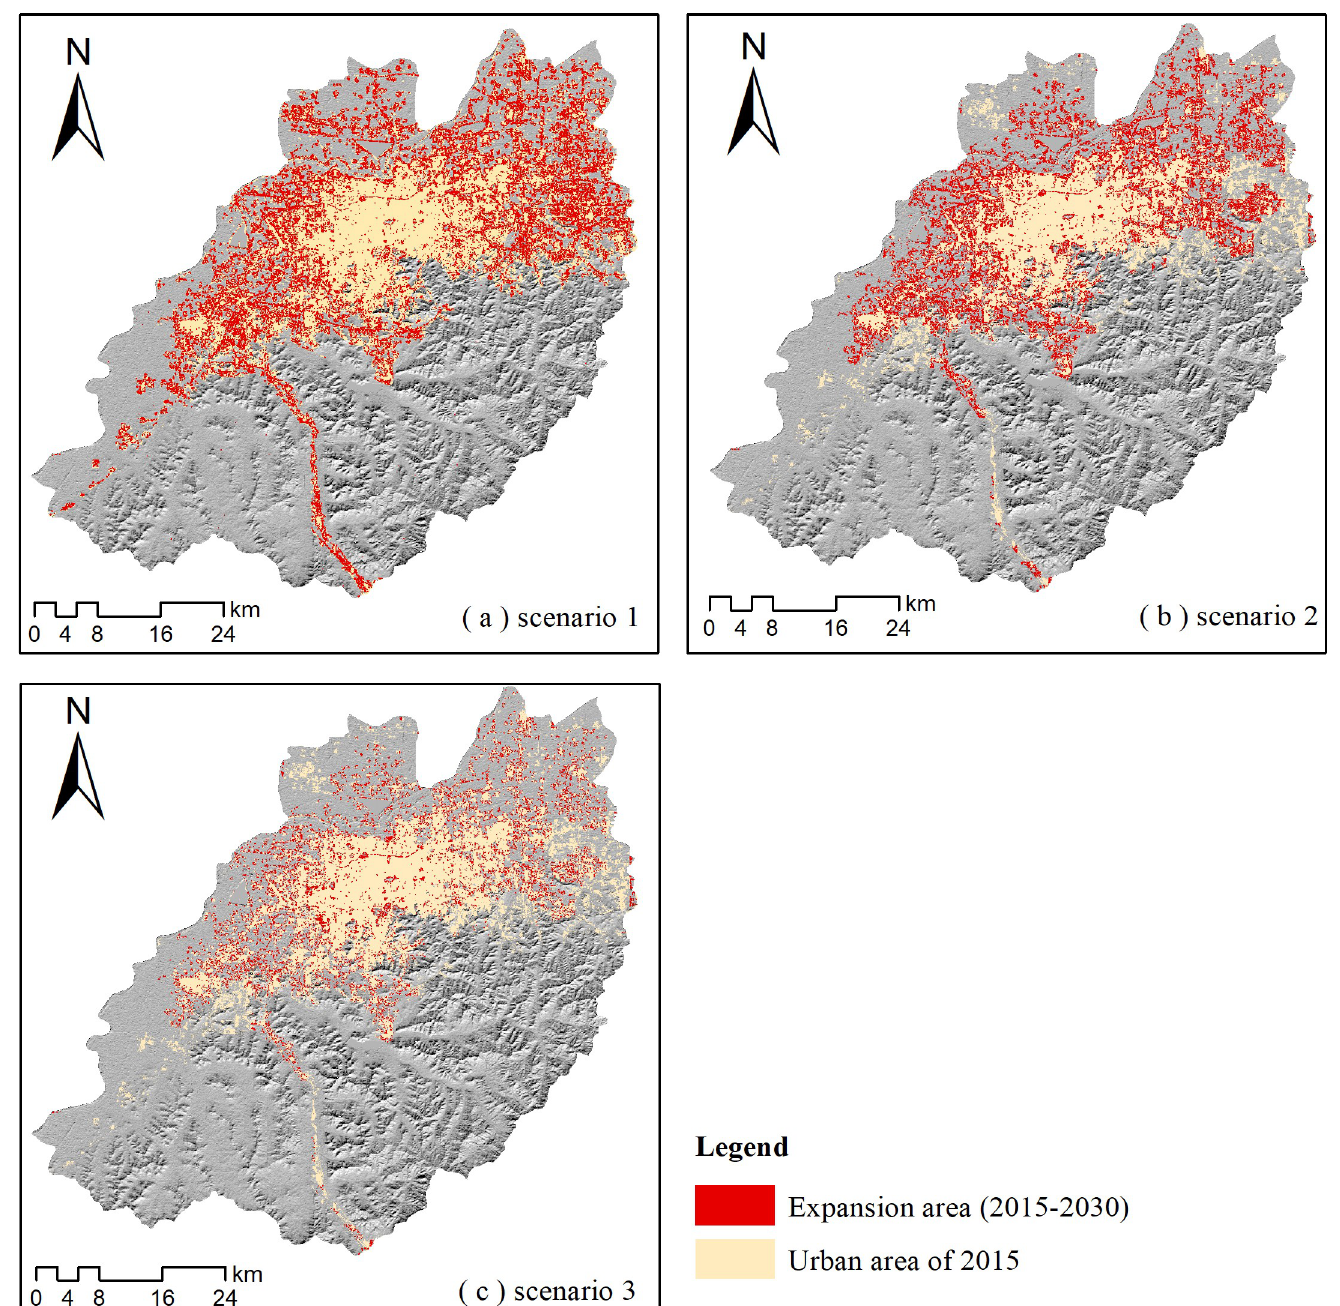
Fig 10. Urban land area predicted under three scenarios by 2030. (a) Scenario 1, historical growth; (b) Scenario 2, gentle restriction of urban expansion; (c) Scenario 3, strict restriction of urban expansion.